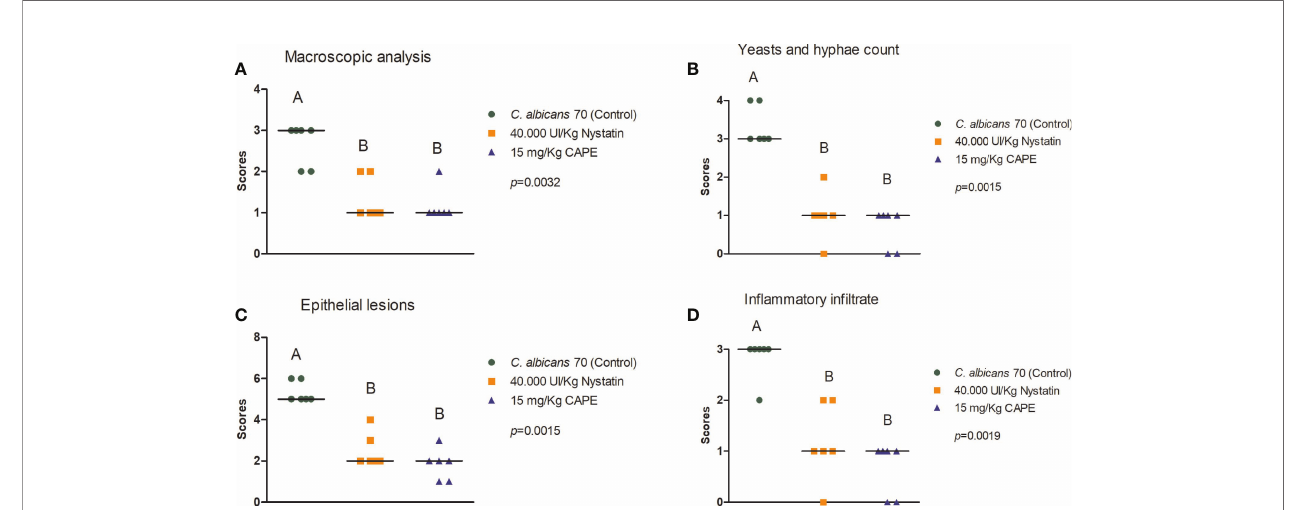
FIGURE 10 | Macroscopic and histological assessment of candidiasis lesions formed on mice ’ s dorsum tongue. Mice were treated with PBS (control group), nystatin or CAPE (A – D) . Scores and median of macroscopic lesions quanti fi cation (A) , Yeasts count and hyphae in PAS stained sections (B) , and epithelial lesions (C) and in fl ammatory in fi ltrate (D) determined in H&E slides (Kruskal-Wallis and Dunn ’ s posttest; statistically signi fi cant differences between groups are represented by different